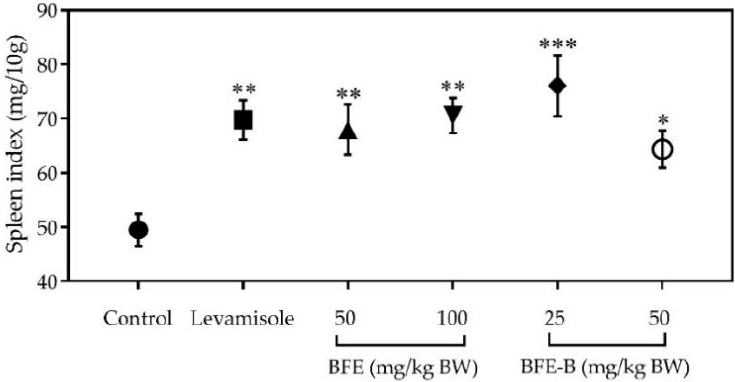
Figure 4. Effect of water-soluble fibers of P. erosus (BFE and BFE-B) on the spleen index of mice induced by hepatitis B vaccine. The data represent the mean ± SEM of five independent measurements. Significant differences compared with the control are determined at * p < 0.05, ** p < 0.01, and *** p < 0.001.